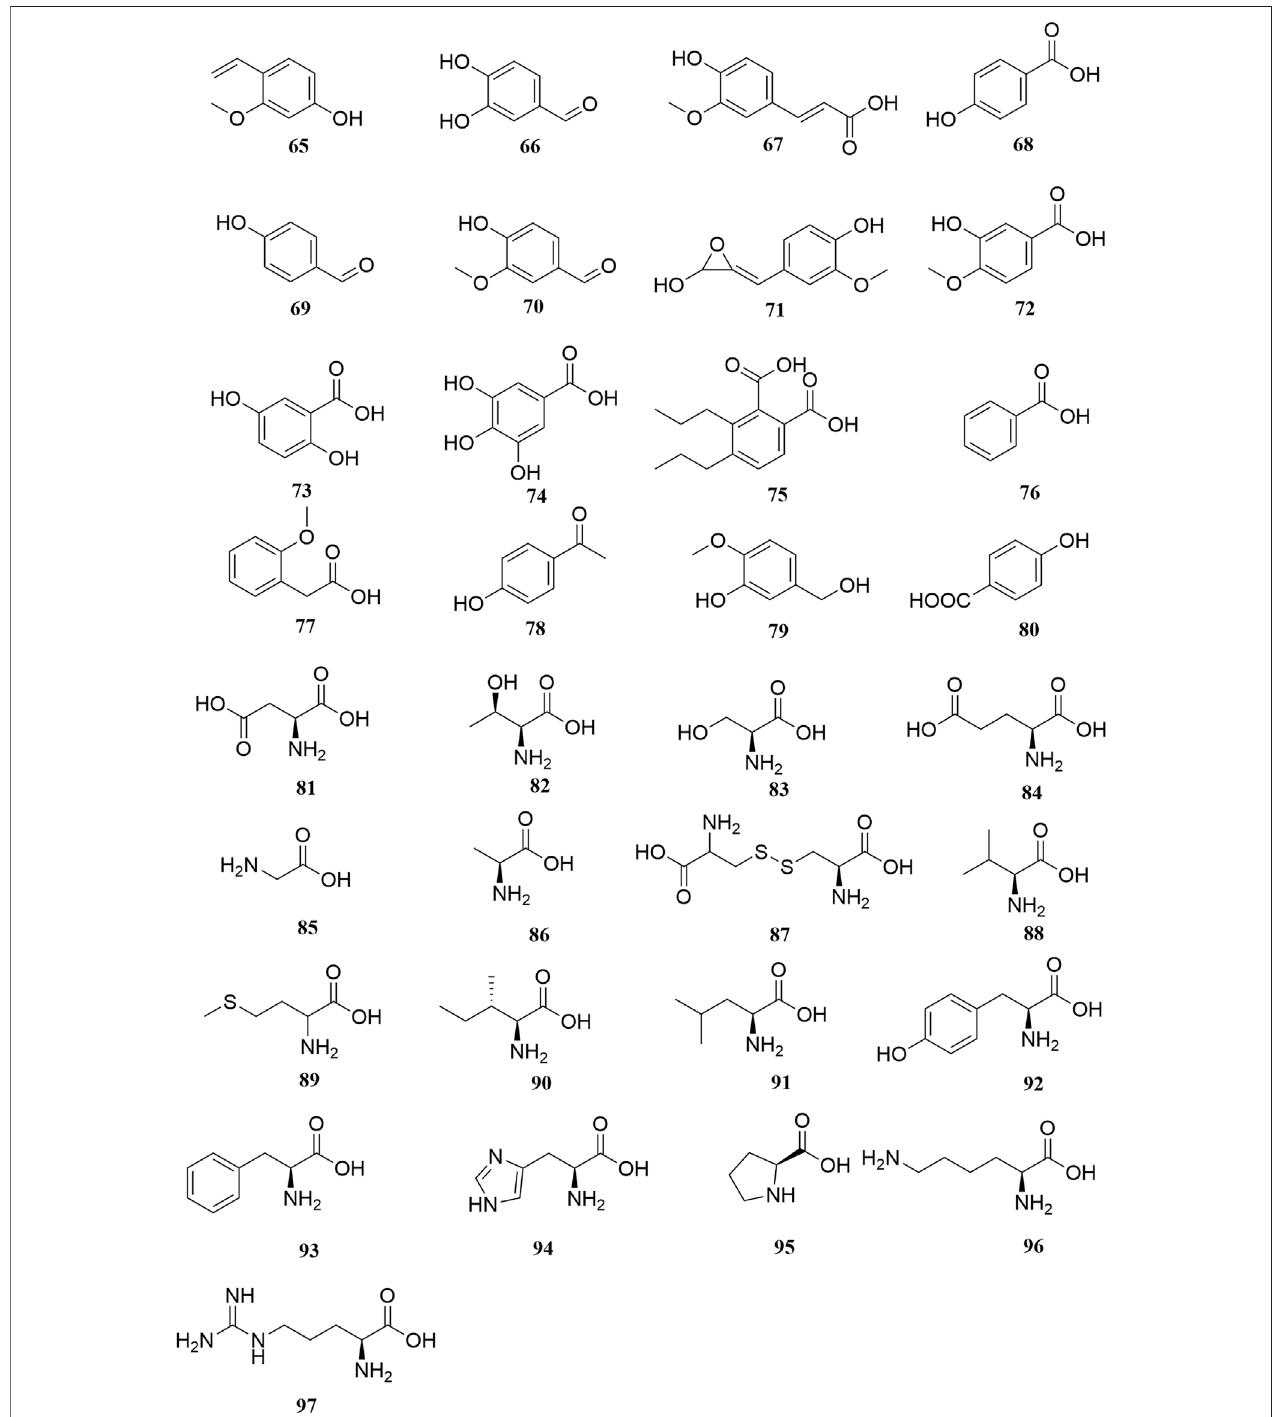
FIGURE 5 | Chemical structures of phenols, phenolic acids and amino acids ( 65 – 97 ).